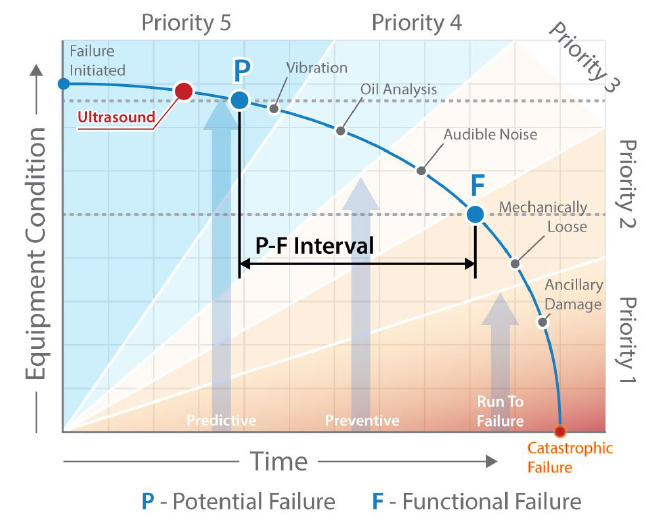
Figure 4. P–F curve [27] shows the interval between potential and functional failure, highlighting possible modes of detection along the